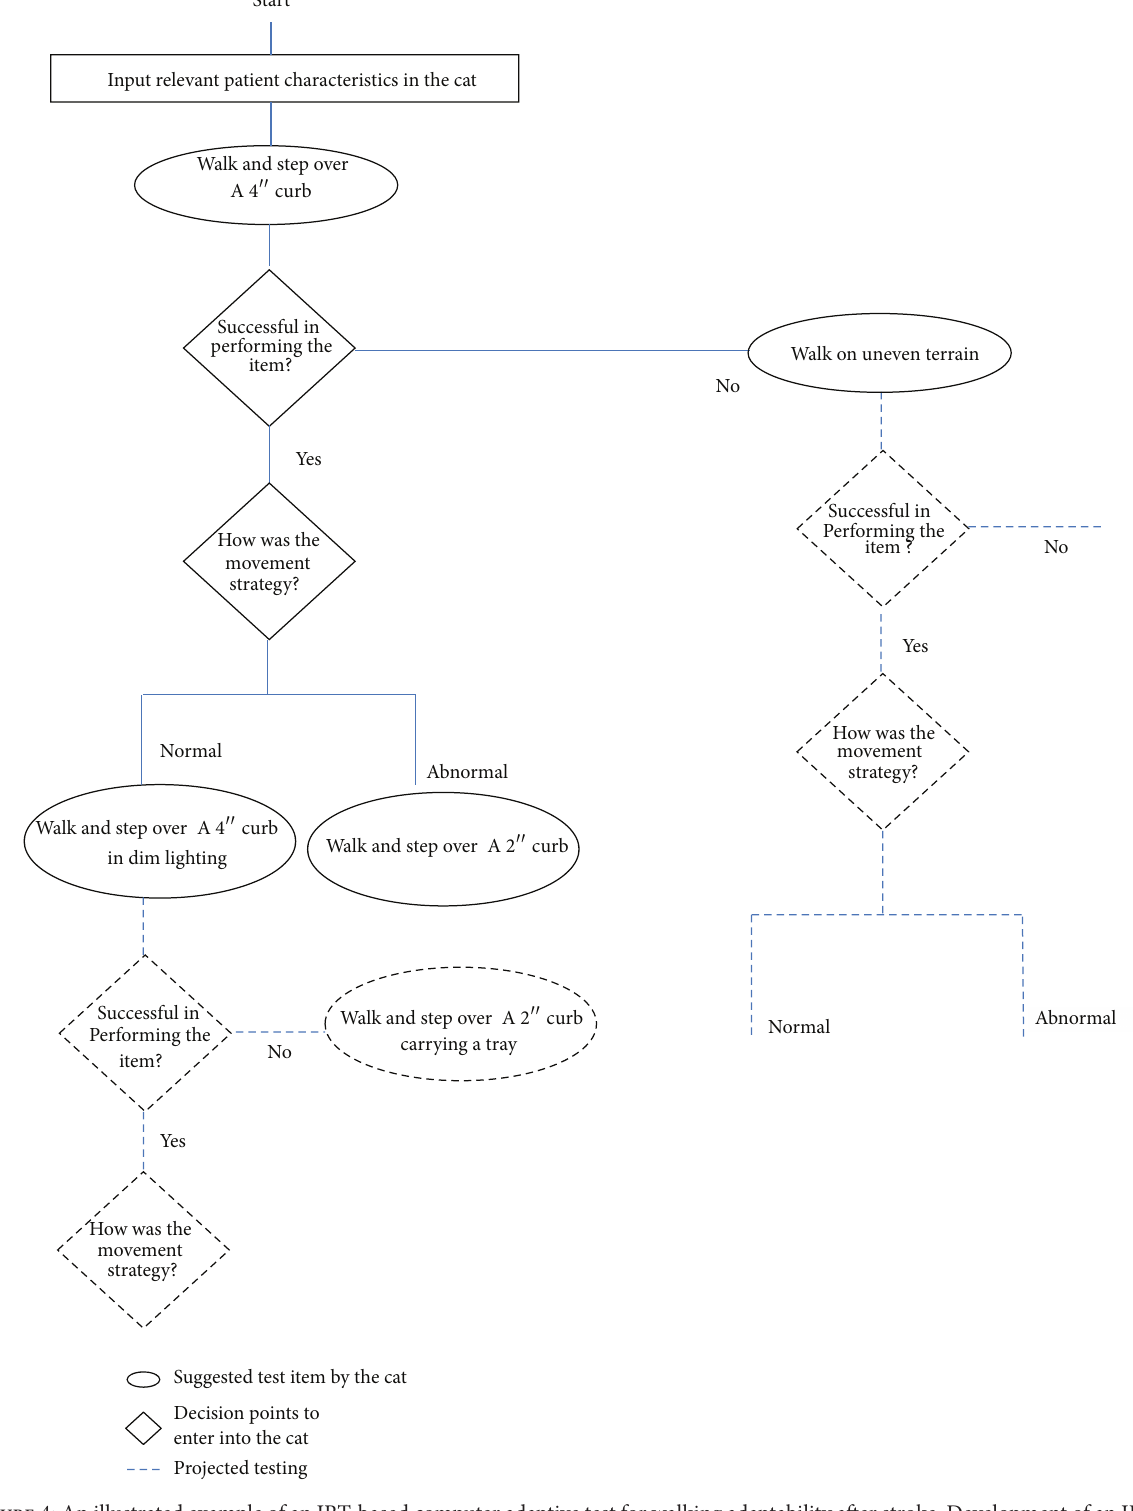
Figure 4: An illustrated example of an IRT-based computer adaptive test for walking adaptability after stroke. Development of an IRT-based assessment requires identification of a relevant pool of assessment items, conceptualizing a hierarchy of difficulty levels, and testing these assumptions using IRT methods. The IRT-based assessment may be administered using a computer adaptive format or an IRT-based static short form. This figure illustrates an example of hierarchical assessment items measuring walking adaptability in the terrain domain and administration of these items in an IRT-based computer adaptive test. Additionally, this example demonstrates incorporating assessment of not only “task performance”, but also the “quality of task performance” (i.e., movement